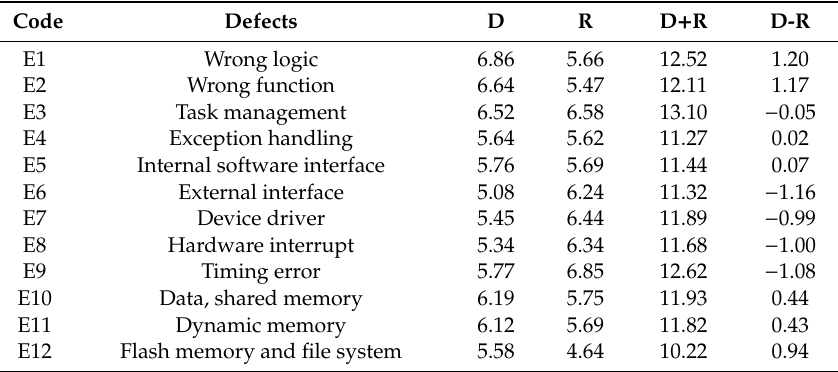
Table 12. Results of the cause and e ff ect analysis of embedded software